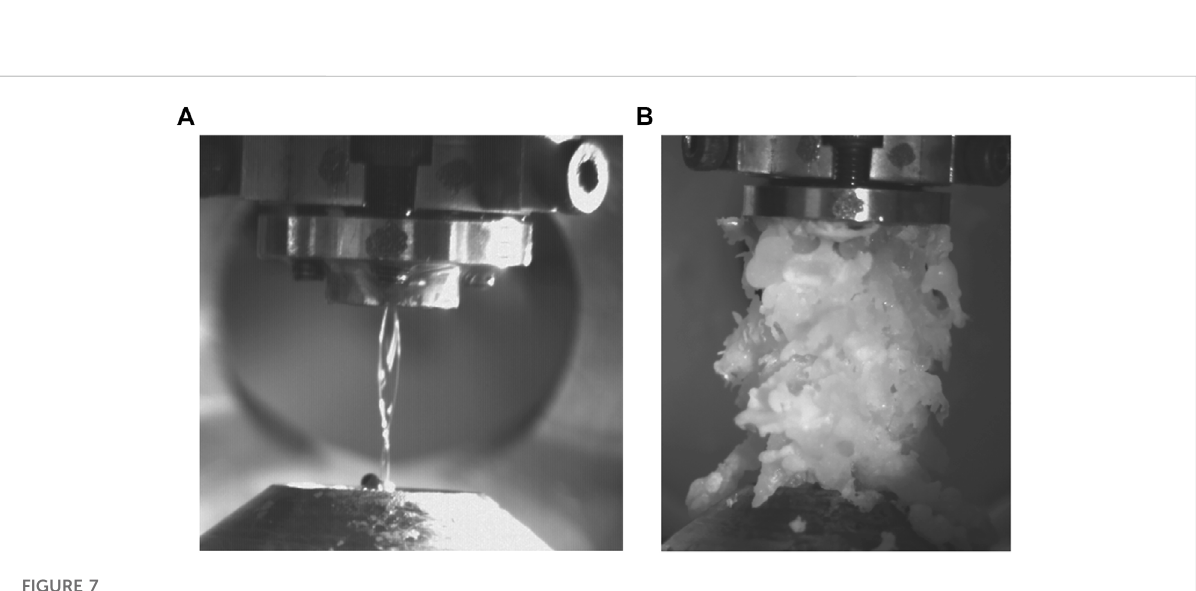
The relationship between jet length, temperature and pressure. (A) The blue curve shows the expected temperature decrease over it is length fora1 cmlongdiamondshapedjetofisopropanolthatis1 mmwideatitsmiddlewitha fl owrateof9.1 ml/min.Theblackdotsareexperimentaldata taken under similar conditions, measured by manually inserting a thermocouple into the sheet. (B) The horizontal vapour distribution at the same vertical positions as the experimental data (listed as P1-5, with one being closest to the nozzle). As can be seen, by the bottom of the sheet (the thinnest and fl attest part, ideal for taking measurements), the vapour density has dropped by two orders of magnitude.